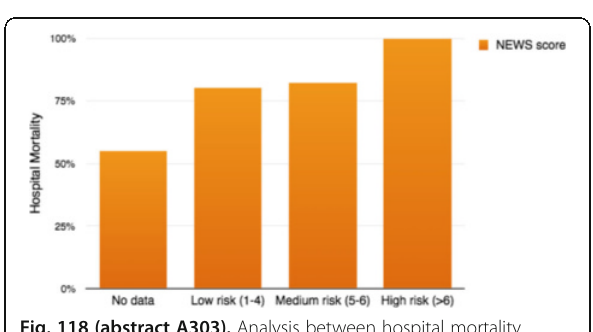
Fig. 118 (abstract A303). Analysis between hospital